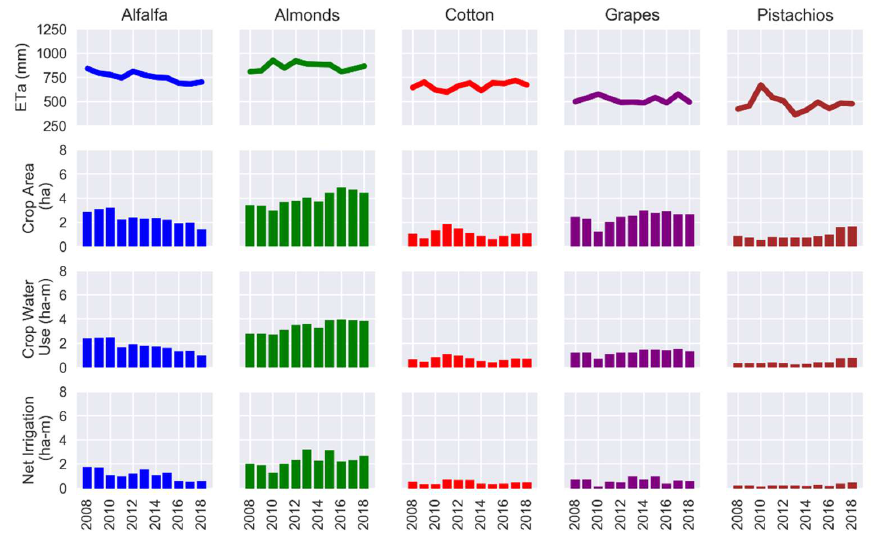
Figure 3. Top five crops in the Central Valley from 2008 to 2018 showing the SSEBop ETa mean (in mm) for the USDA-NASS CDL crop type, the bias-corrected area estimate (ha), water use volume (ha-m) and the net irrigation (ha-m). The area, water use, and net irrigation are scaled by 100,000 (i.e., 4 ha-m corresponds to 400,000 ha-m). 1 hectare = 2.47 acres. 1 hectare-meter = 8.107 acre-feet. Table 4. Volumetric water use estimates for the top 10 major crops in the Central Valley from 2008 to 2018 ordered by the mean including: (1) the 2008–2018 mean water use, (2) the water use in 2008 including the percentage of the total, (3) the water use in 2018 including the percentage of the total, (4) the % change in crop water use between 2008 and 2018, and (5) the mean crop water use during the 2012–2016 California drought and percent deviation from the mean.